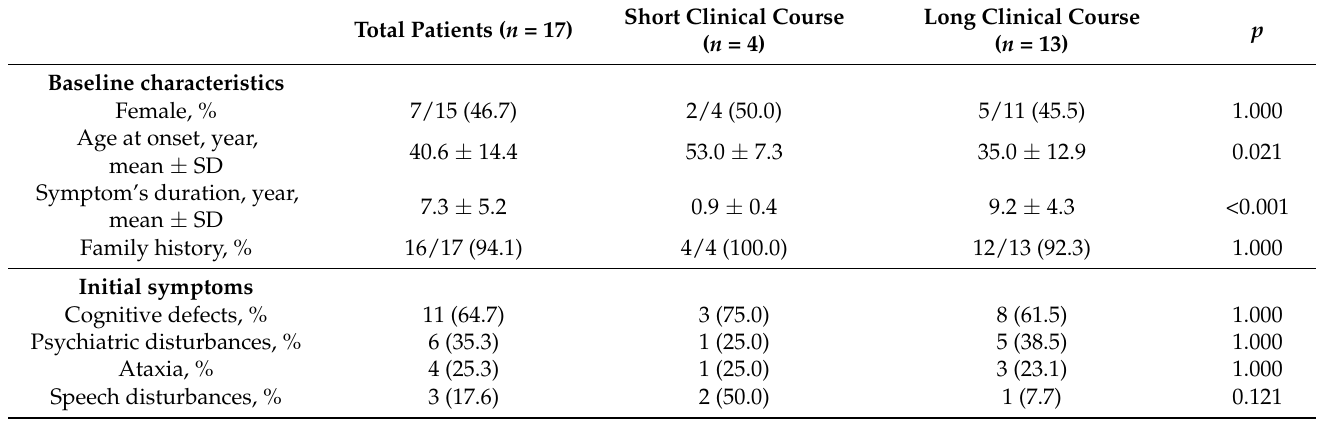
Table 1. Comparison of clinical and auxiliary characteristics of diseases with short-term and long-term